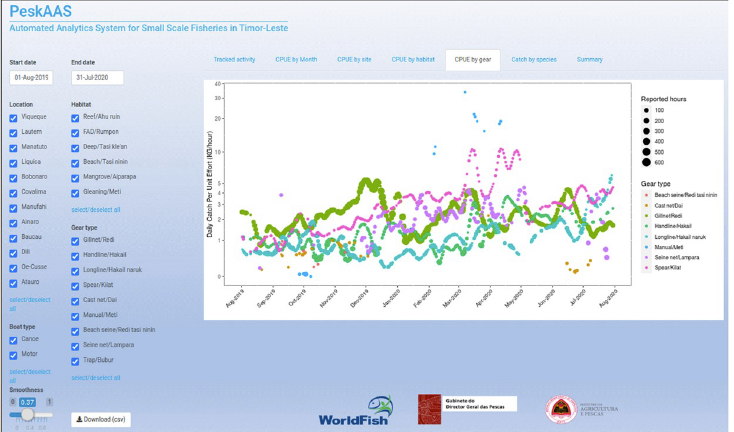
Fig 1. Screenshot from the interactive PeskAAS dashboard developed to visualise near-real time fish landings data in Timor-Leste.